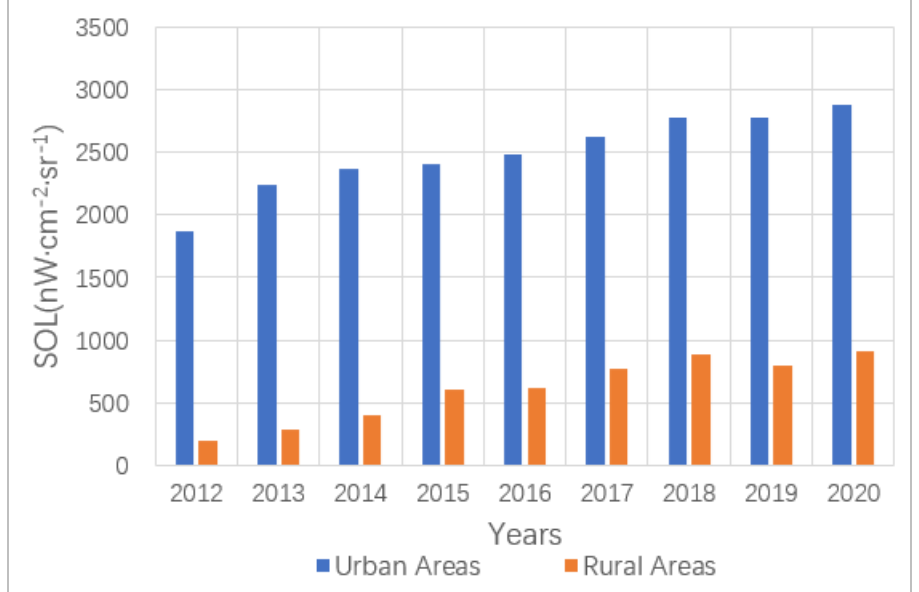
Figure 9. SOL of the urban and rural areas in Rwanda from 2012 to 2020.